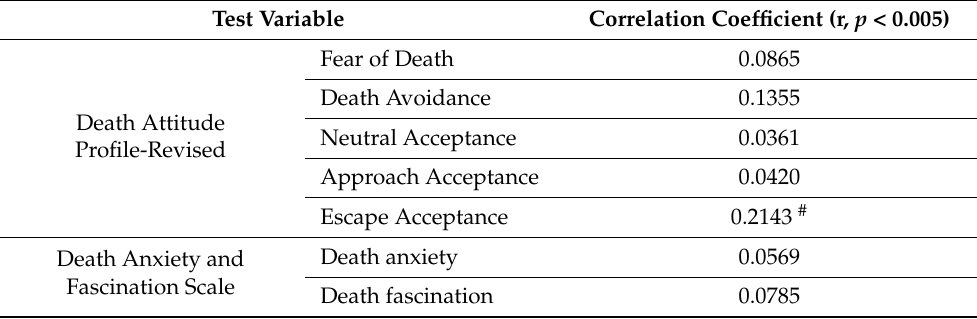
Table 6. Correlation coefficients of the seniority effect on nurses’ attitudes toward